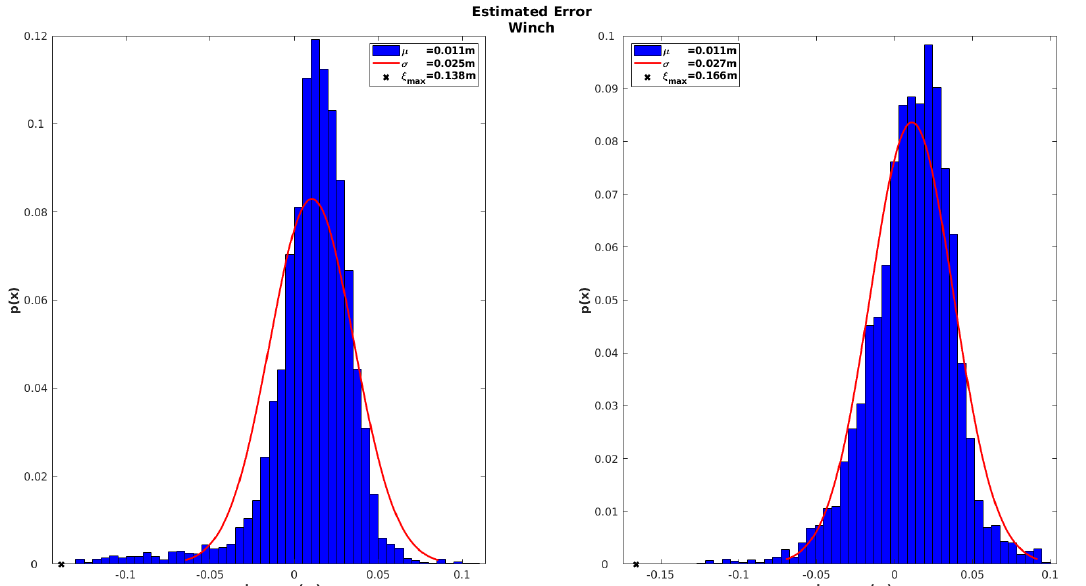
Figure 17. Absolute position error obtained for the two observation models combined, assessed through the innovation sequence of the winch